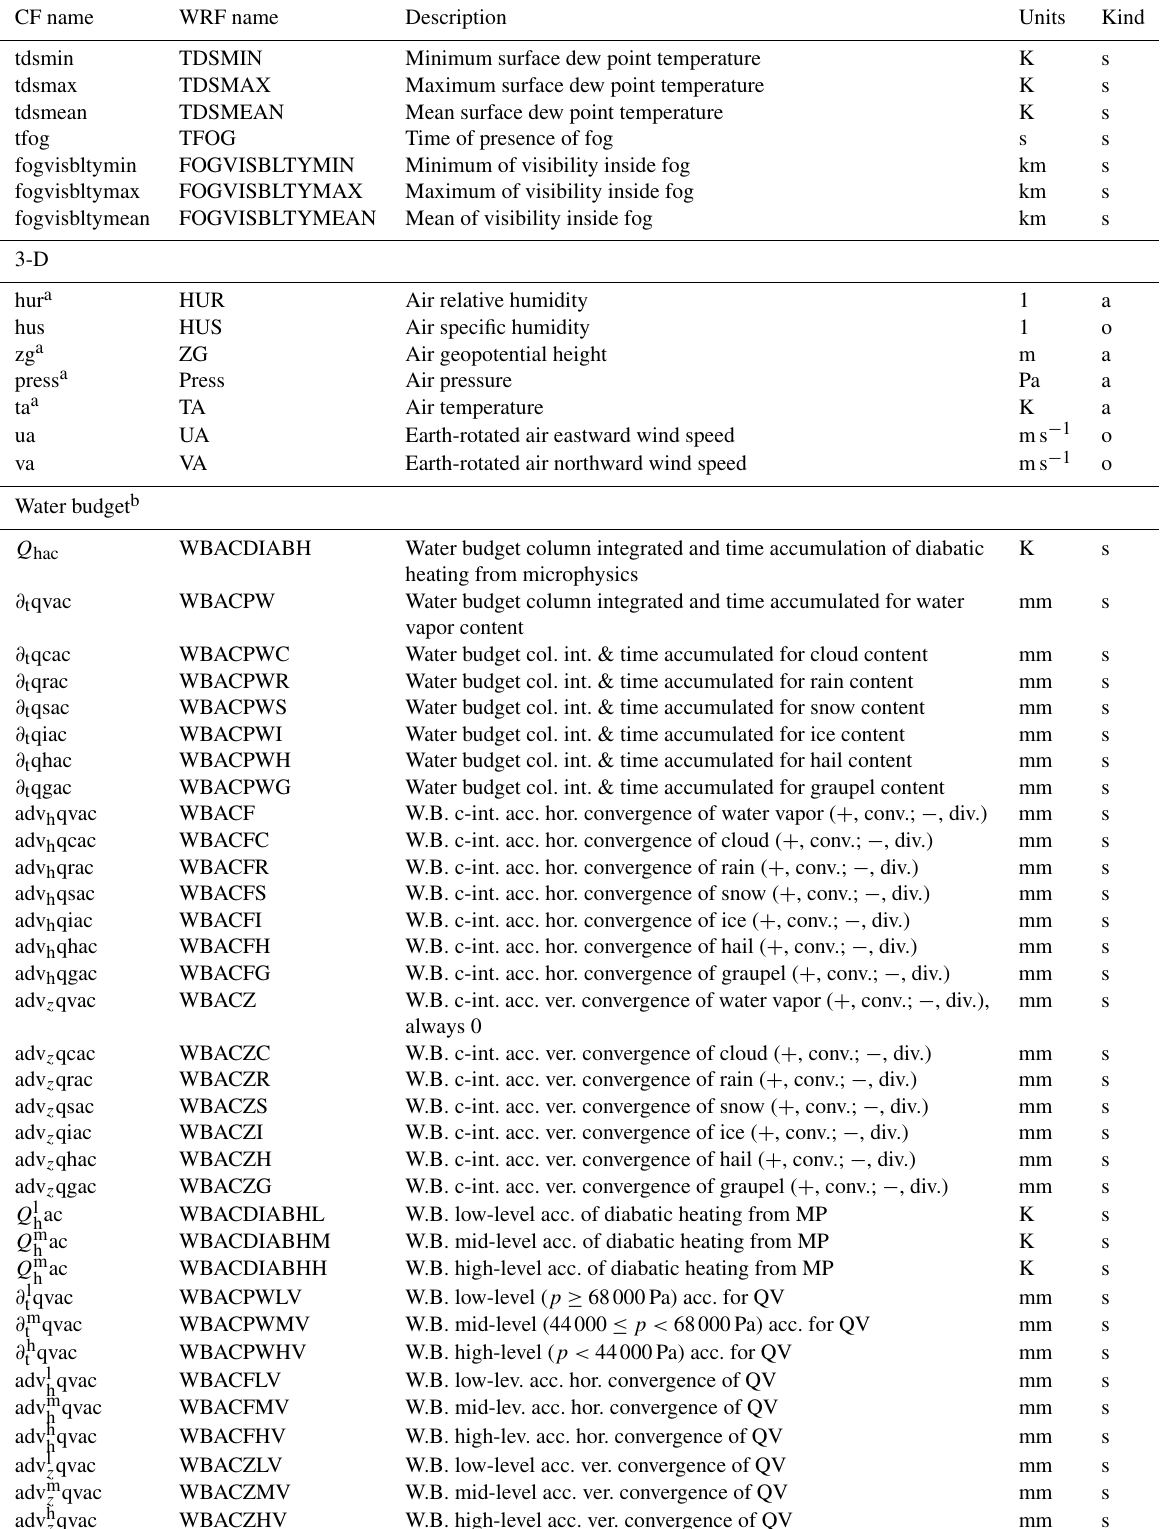
Table B3. As in Table B1, but for the description of additional variables provided with the